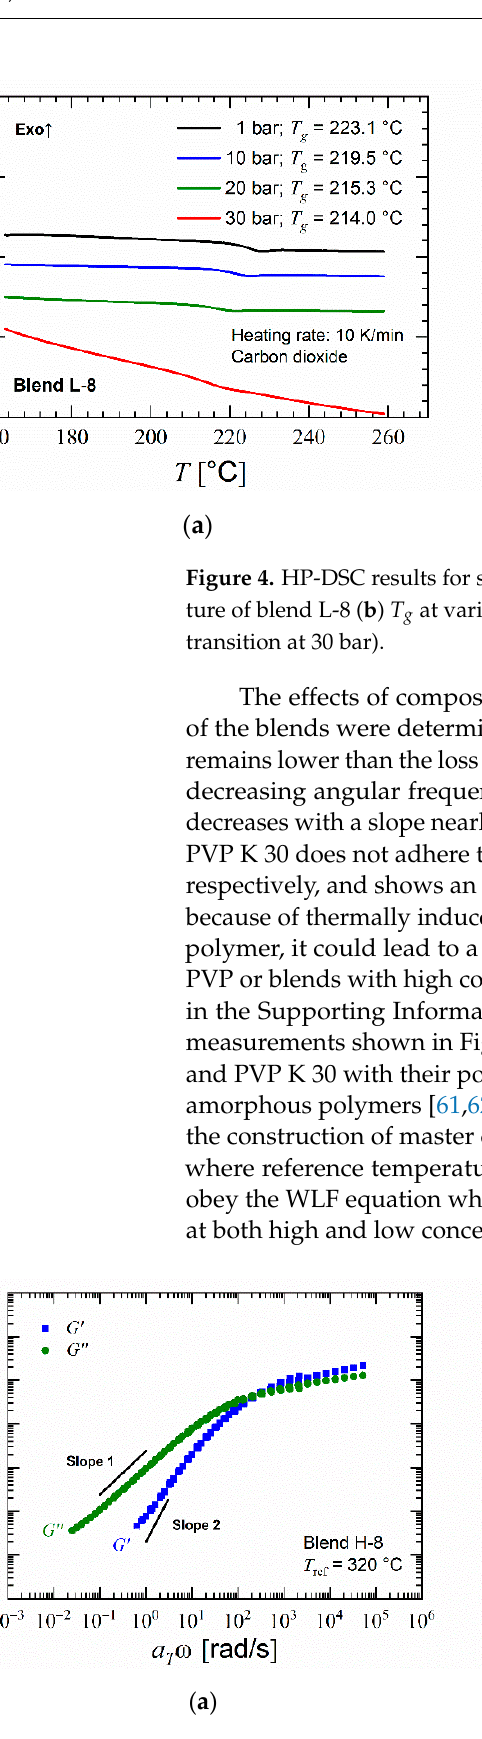
( d ) Figure 5. Rheological analysis of selected materials: ( a , b ) Master curve of blends H-8 and H-32; ( c , d ) Shift factor and WLF fit of blends H-8 and H-32. 4.2. Batch Foaming In the experiments where CO 2 was used as a foaming agent, all selected materials yielded mostly closed-cellular foams. PVP K 30 delivered the lowest density foams among all materials in most trials. However, in some trials, during the foaming stage, the PVP samples initially grew into 3–4 times the original size as observed visually, and collapsed instantaneously after 45 to 60 s of exposure to the foaming temperature. This foam collapse occurred only when the loading pressure was set to 50 bar but did not occur in the trials conducted at 100 bar. As PVP is a highly elastic material in the melt state, the expansion caused by bubble growth is easily reversed, thus attaining the original size. Figure S10 in the Supporting Information show that this collapse has resulted into a crushed foam structure. Foams of blends with 32% PVP had the highest porosity among the blends. This increase in porosity due to increase of PVP content supports the findings by Shi et al. [41] where the increase in the polymer content of the minor component in the single-phase polymer blend yielded in higher porosity. Although majorly closed microcellular foams, the blends L-8 and H-8 exhibit a certain nanoscale structure on the cell-walls of the microcellular foams as shown in Figure 6. As discussed in the Introduction, many researchers have found this structure in foams of various polymers at certain processing conditions. Fukasawa et al. [65] and Gong et al. [19] found a similar structure in polycarbonate foams under certain processing conditions. Their structure consisted of partially open pores formed within this structure. Fukasawa et al. [65] linked the formation of these pores to the crystallization of polycarbonate